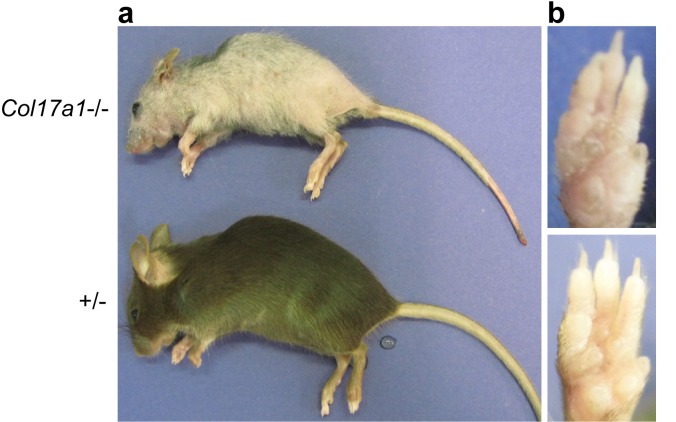
Gross appearance of Col17a1−/− and littermate controls (3 months old).(a) Gray and sparse hair was noted in Col17a1−/− skin. (b) Scaly paw skin was observed in Col17a1−/− skin (representative images from four mice).